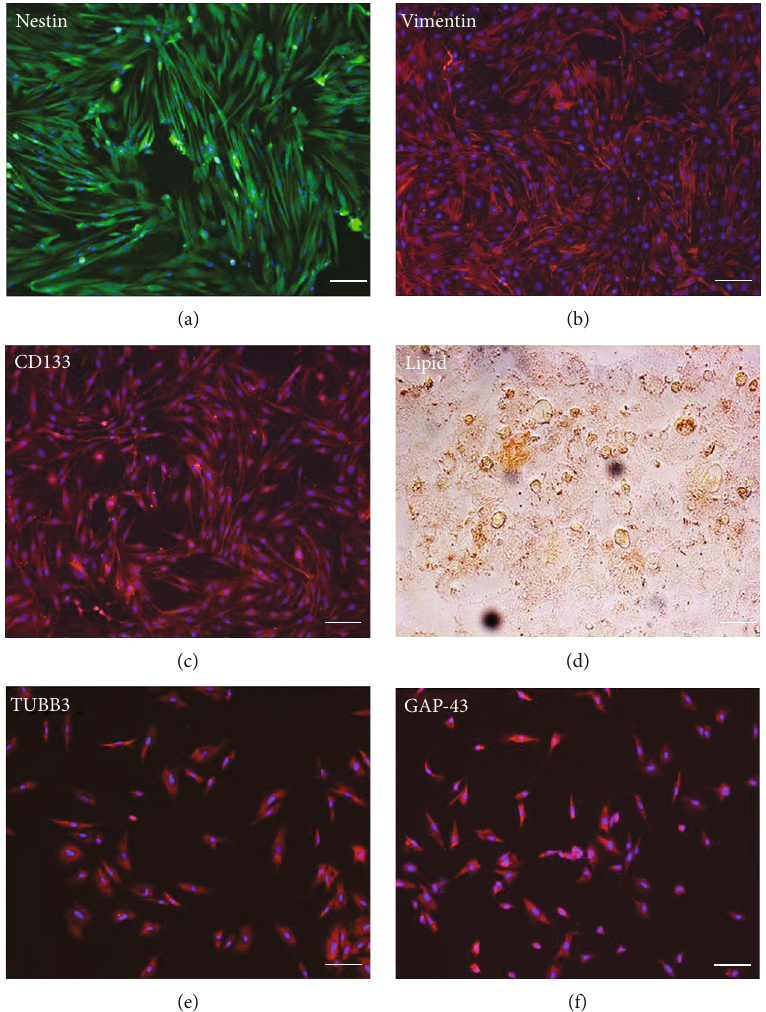
Figure 1: Isolation and characterization of EMSCs. (a – c) Immunostaining of tendon-derived cells using antibodies against nestin, vimentin, and CD133. Multilineage di ff erentiation potential: (d) oil red O staining (adipogenesis) and (e, f) TUBB3 and GAP-43 immunostaining for EMSC neural di ff erentiation. Bar = 25 μ m